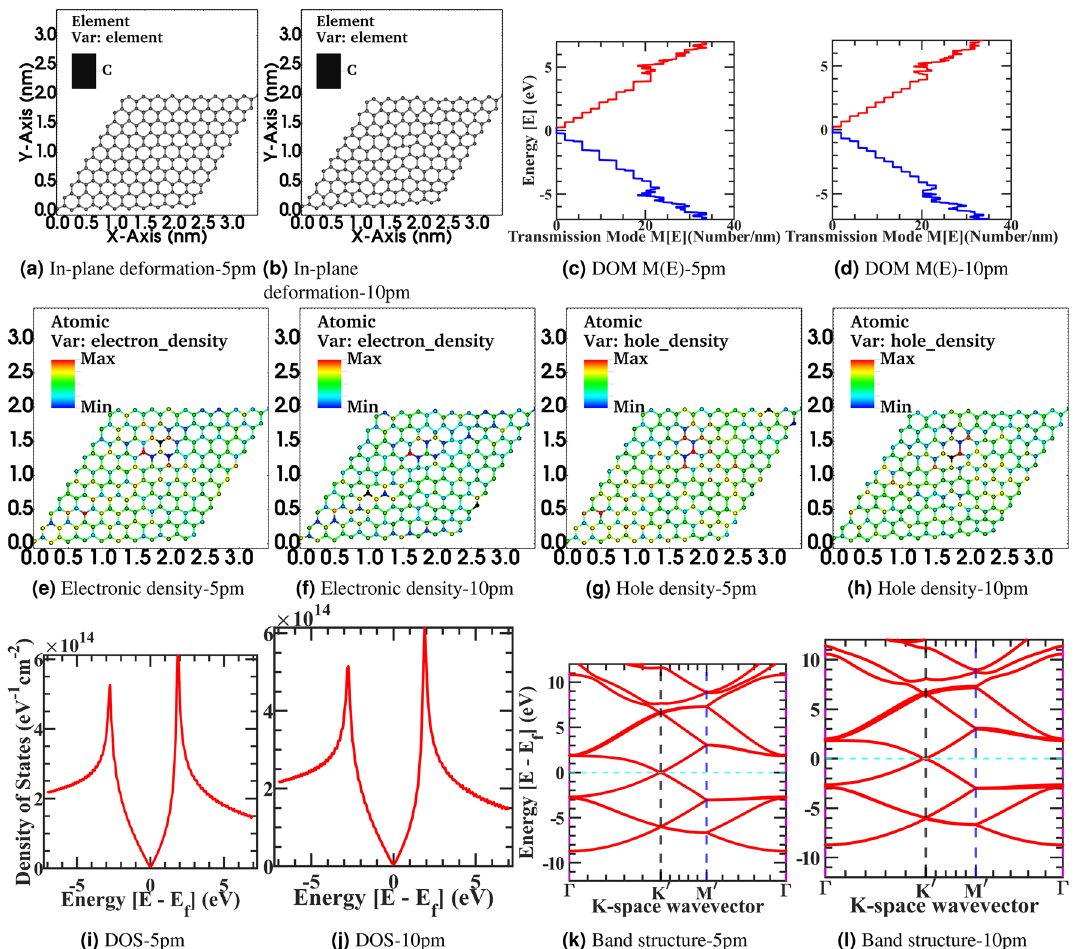
Figure 4. Device structure 10x10 graphene supercell ( a , b ) in-plane deformation roughness-5pm to −10pm, Electronic density of modes M(E) in x-y Direction ( c , d ) in-plane deformation-5pm to −10pm, Electronic density ( e , f ) in-plane deformation-5pm to -10pm, Hole density ( g , h ) in-plane deformation-5pm to −10pm, Density of state ( i , j ) in-plane deformation-5pm to −10pm, and Electronic band structure ( k , l ) in-plane deformation-5pm to